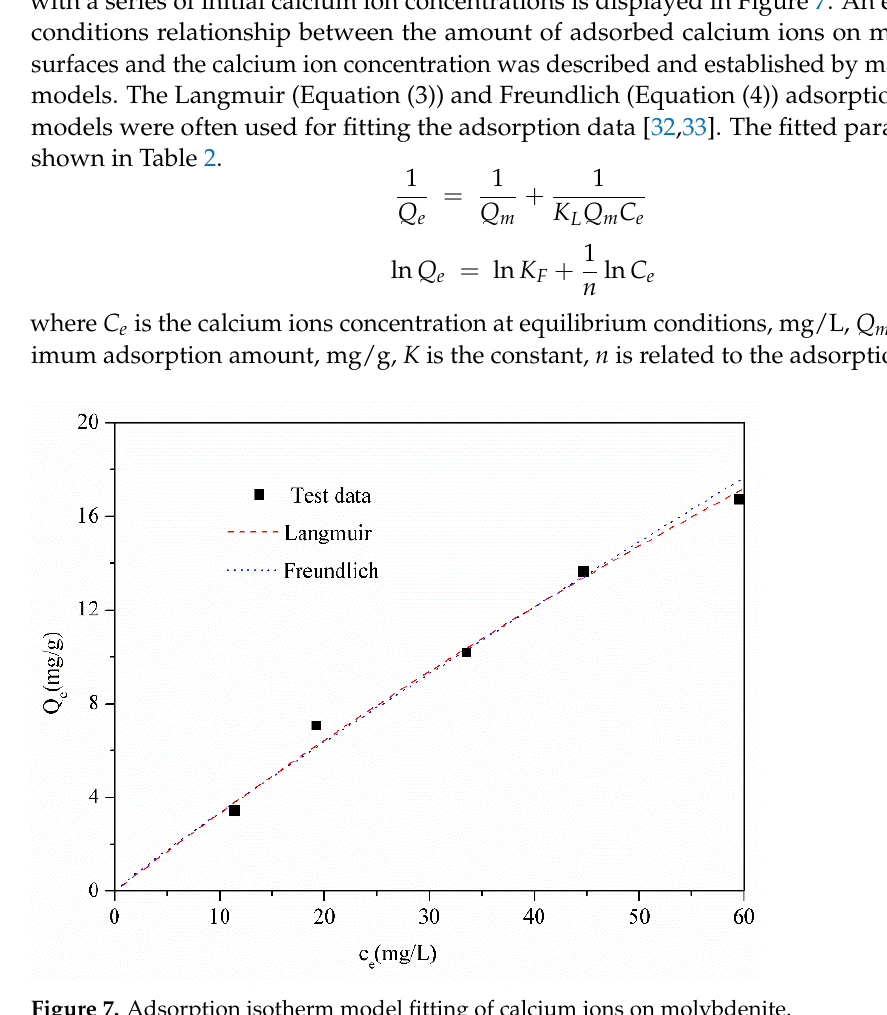
Figure 7. Adsorption isotherm model fitting of calcium ions on molybdenite. Table 2. Adsorption isotherm fitting parameters.